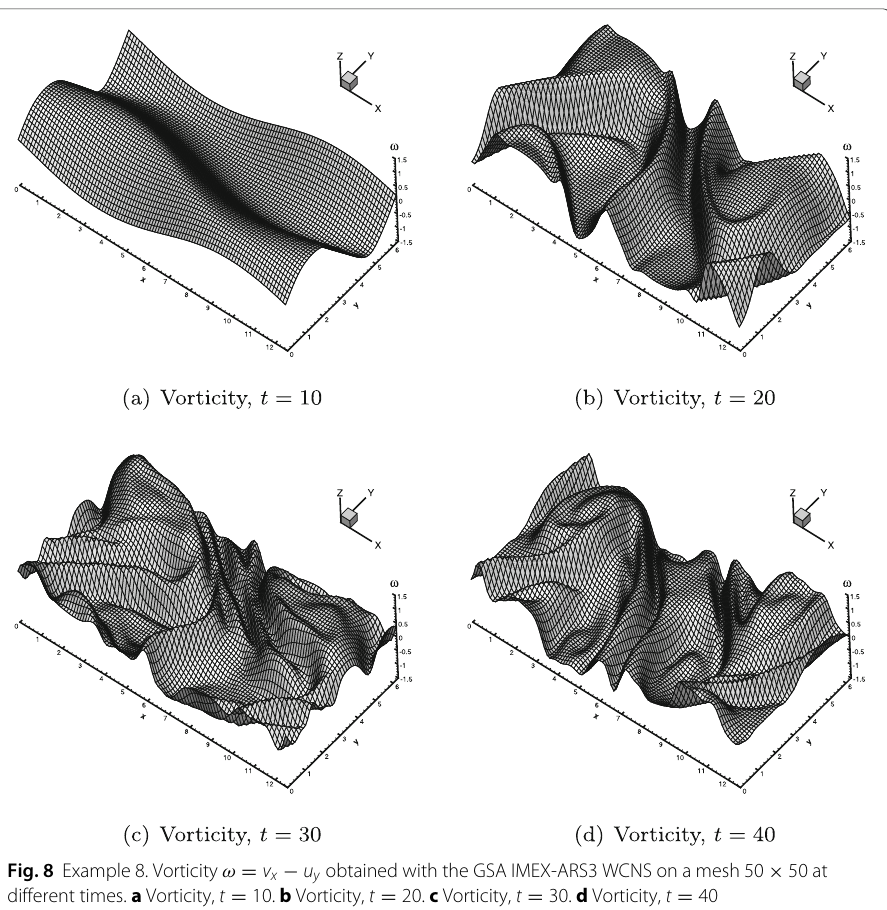
Fig. 8 Example 8. Vorticity ω = v x − u y obtained with the GSA IMEX-ARS3 WCNS on a mesh 50 × 50 at different times. a Vorticity, t = 10. b Vorticity, t = 20. c Vorticity, t = 30. d Vorticity, t = 40